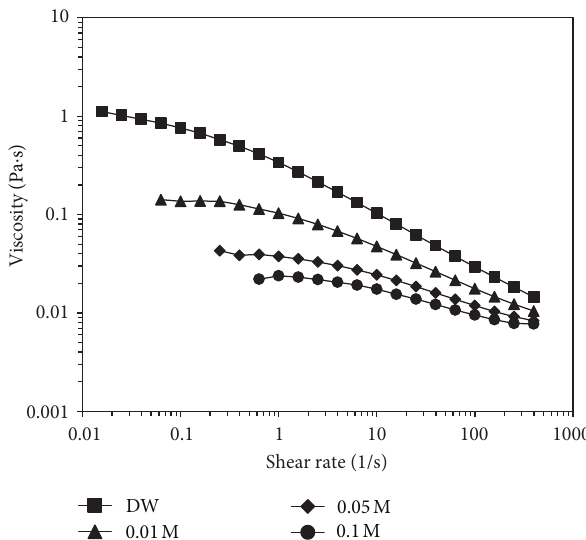
Figure 18: Effect of sodium sulphate concentration on steady shear viscosity of copolymer at 50 ∘ C.